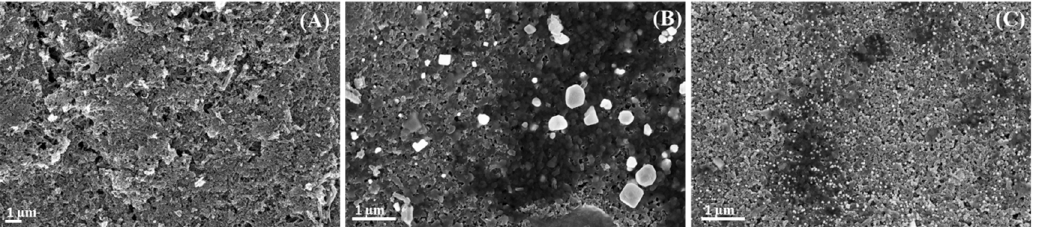
Figure 3. Scanning electron microscopy micrographs of ( A ) bare screen-printed carbon nanofiber electrode (SPCNFE), ( B ) G-AgNPs-SPCNFE, and ( C )